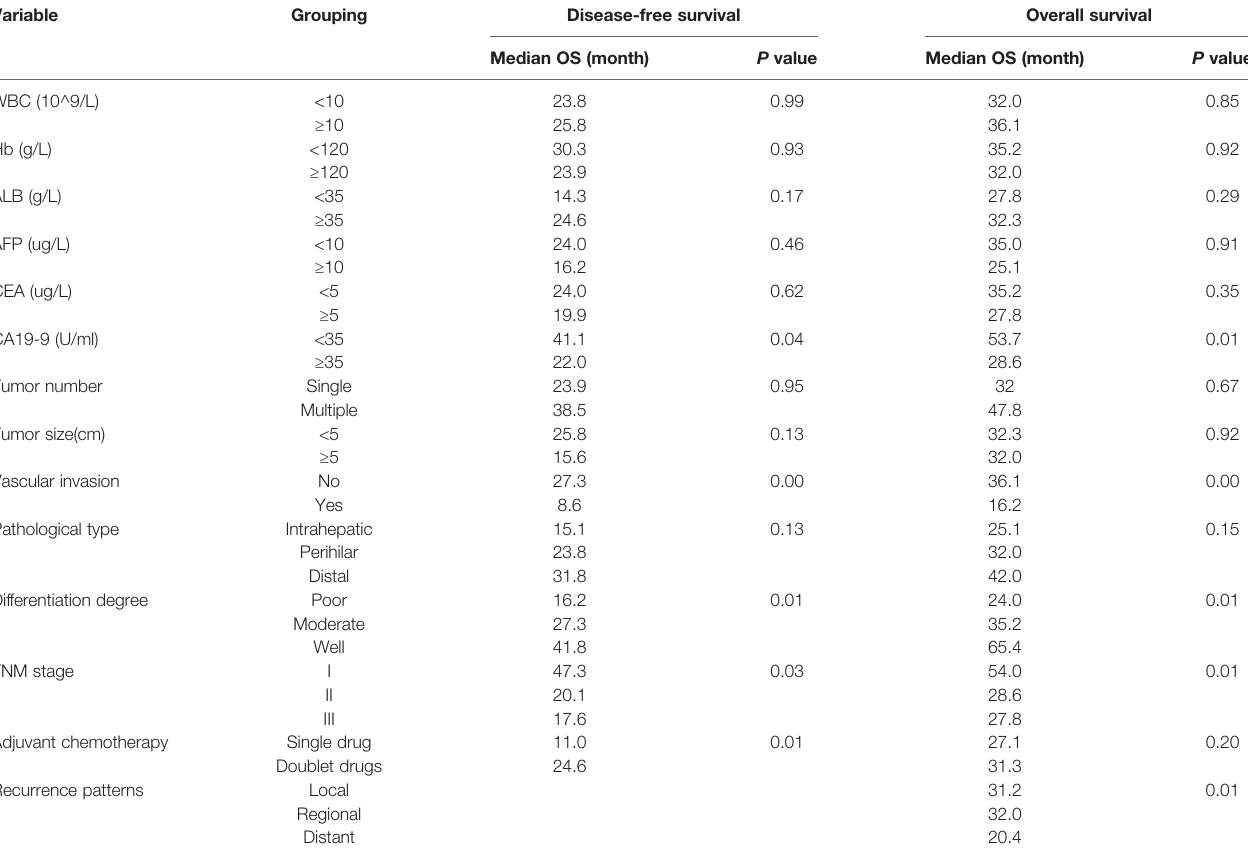
TABLE 2 | Results of univariate analysis of disease-free survival and overall survival after cholangiocarcinoma radical surgery. Variable